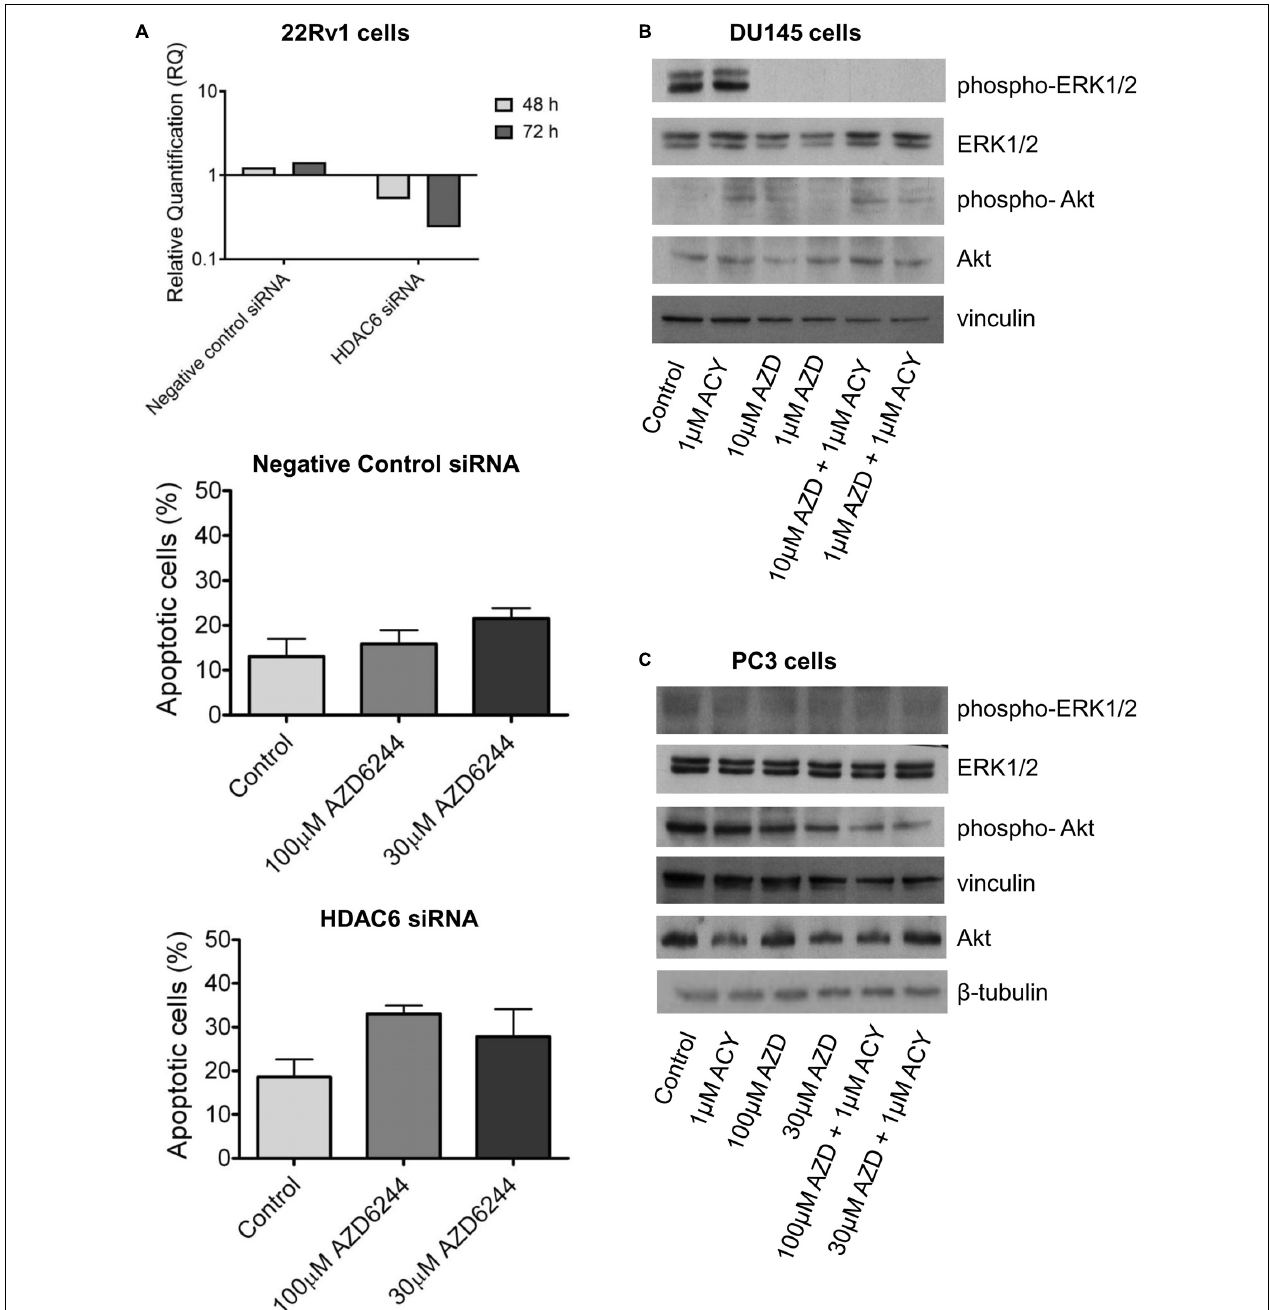
FIGURE 2 | HDAC6 loss of function studies in 22Rv1 cells and analysis of target modulation in prostate carcinoma cells exposed to the combination of AZD6244 and ACY1215. Knockdown of HDAC6 by siRNA transfection in 22Rv1 cells. qRT-PCR analysis of HDAC6 mRNA levels at different times after transfection start; untrasfected cells were used as calibrator and GAPDH as housekeeping gene. Analysis of apoptosis in transfected cells exposed to MEK inhibitor AZD6244 for 24 h. At the end of treatment cells were harvested for analysis of apoptosis by Annexin V binding assay (A) . Western blot analysis (B,C) of possible targets was carried out in DU145 and β -tubulin (B) and PC3 (C) cells incubated with AZD6244 and ACY1215 or their combination, according the most favorable schedule. Control loading is shown by vinculin. The protein band intensity was quantified using ImageJ, normalized to that of the loading control and expressed relative to the level of control cells (set to 1). Normalized values corresponding to 1 µ M ACY1215, 10 µ M AZD6244, 1 µ M AZD6244, 10 µ M AZD6244 plus 1 µ M ACY1215, 1 µ M AZD6244 plus 1 µ M ACY1215 were 1.30, 0.02, 0.04, 0.02, 0.003 for phospho-ERK1/2; 1.35, 1.34, 1.29, 2.66, 2.43 for ERK1/2; 6.91, 9.92, 5.88, 16.59, 4.55 for